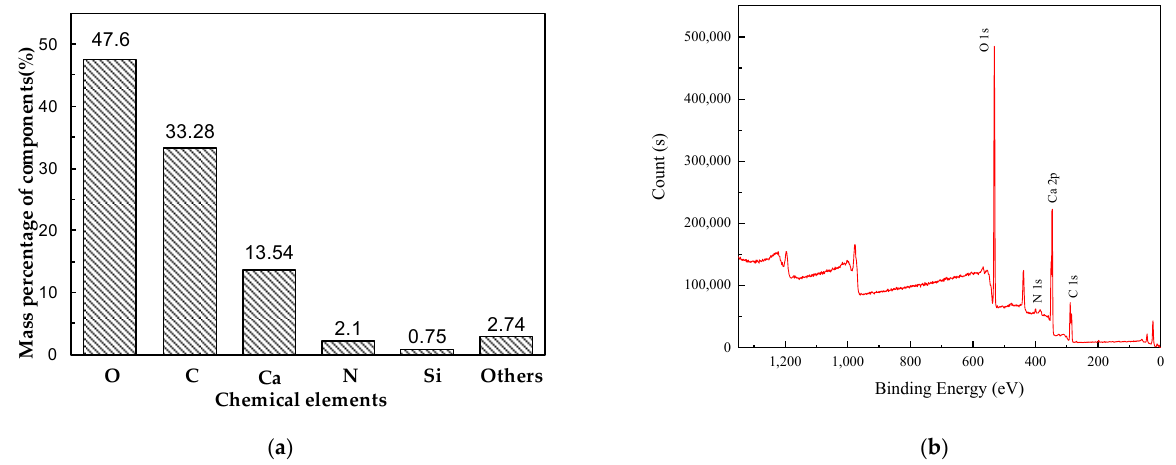
Figure 6. XPS analysis results: ( a ) the mass percentage of main components and ( b ) a representative XPS spectra graph. Combined with the micromorphologies and the elements mass percentage of the components, solid precipitates might consist of calcium carbonate and grouting materials.